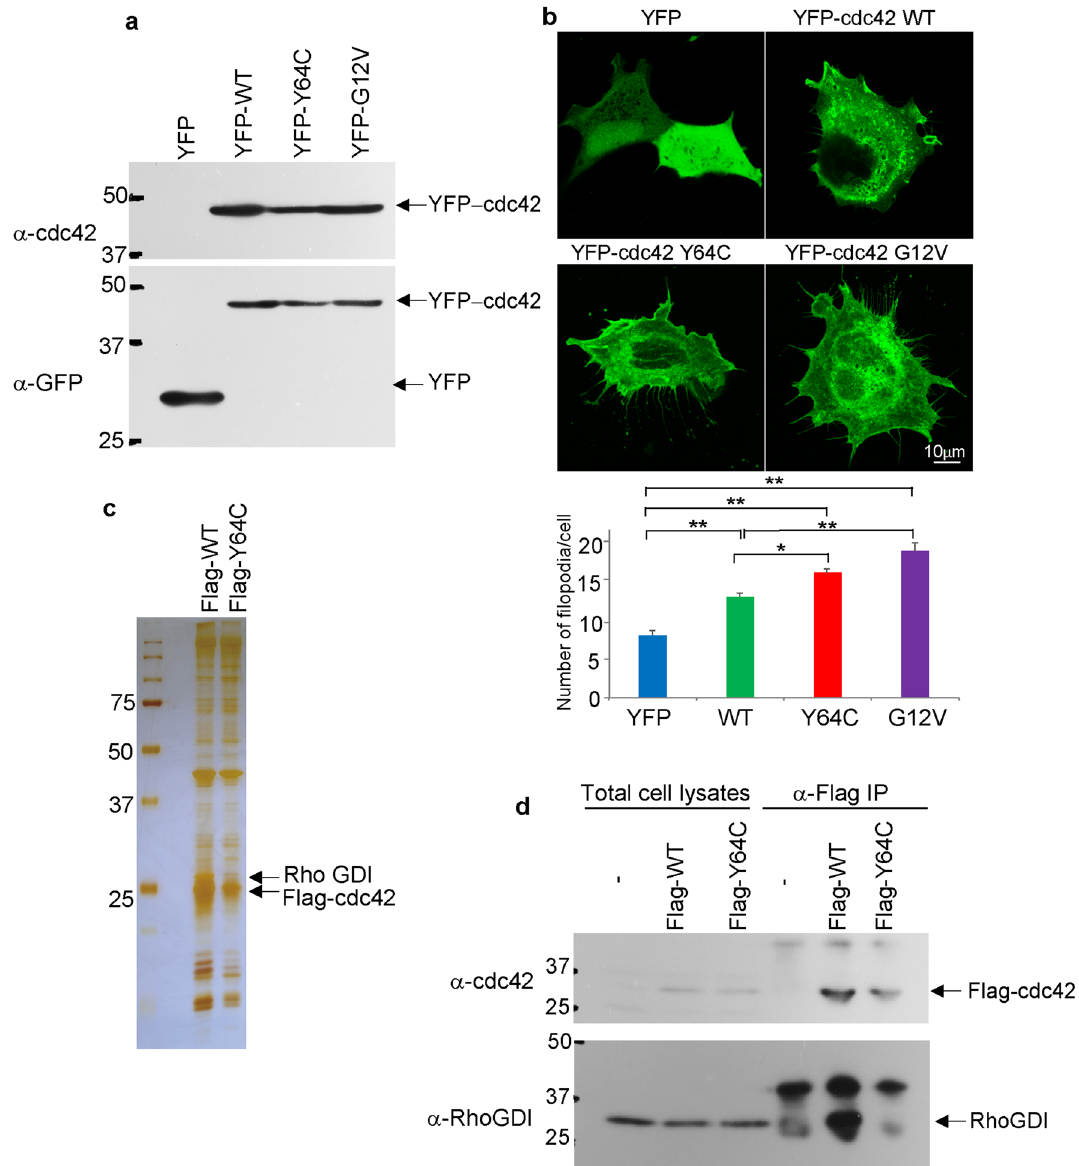
Figure 1. Cdc42-Rho-GDI association was suppressed by Y64C expression. ( a ) Total cell lysates from HEK293 cells transiently expressing EYFP-tagged WT or Cdc42 variants were subjected to SDS-PAGE followed by Western blotting using the indicated antibodies. ( b ) Upper panel; Cellular morphology of EYFP-Cdc42s expressing HEK293 cells. Lower panel; The number of filopodia per cell was counted in at least 50 cells and quantified. Data are the mean ± SEM * P < 0.05, ** P < 0.01 ( c ) Flag-tagged WT or Y64C was introduced into HEK293 cells by lentivirus and immunopurified using anti-Flag agarose. The eluates were subjected to SDS- PAGE followed by silver staining. The bands (arrows) were subjected to in-gel digestion followed by peptide mass fingerprinting. ( d ) Co-IP assay was performed using anti-Flag antibody and Cdc42-Rho-GDI association was confirmed by Western blotting using the indicated antibodies. Full length blots and a gel are presented in Supplemental Fig.